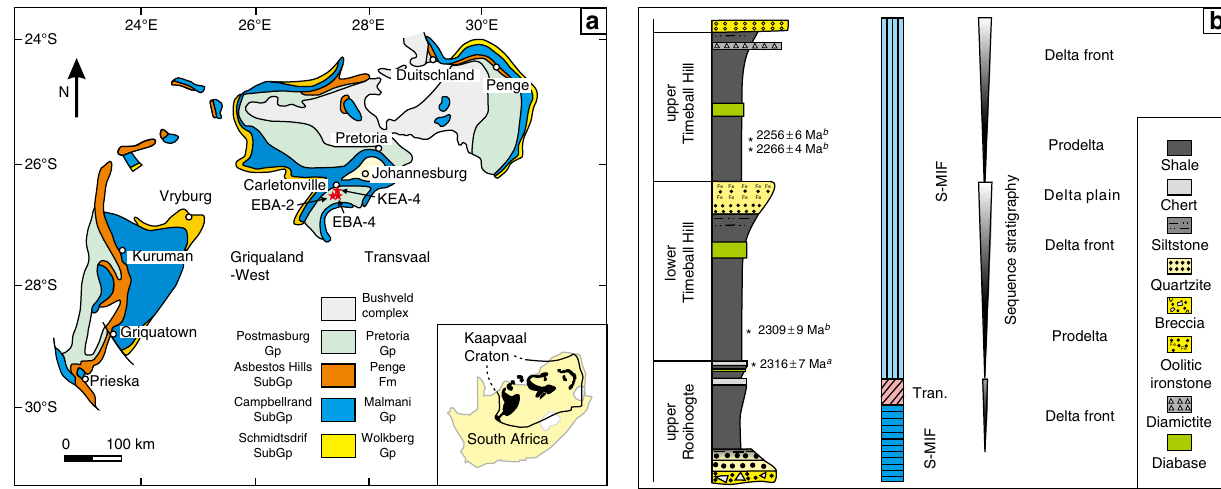
Fig. 1 Geological map and idealised stratigraphy of the study area. a A simpli fi ed geological map of the Transvaal Supergroup preserved on the Kaapvaal Craton. b Composite stratigraphy of the studied succession in the Carletonville area. The stars in a locate the three cores analysed in this study. The geological map is modi fi ed from Sumner and Beukes 74 . The generalised lithological column, sequence stratigraphic and facies analysis follow refs. 28, 29 . Note that stratigraphic column is not to scale. Age constraints: a Hannah et al. 21 , b Rasmussen et al. 22 . Quadruple sulphur isotope stratigraphy follows Luo et al. 20 . Gp: group, S-MIF: sulphur mass-independent fractionation, S-MDF: sulphur mass-dependent fractionation, Tran.: transitional